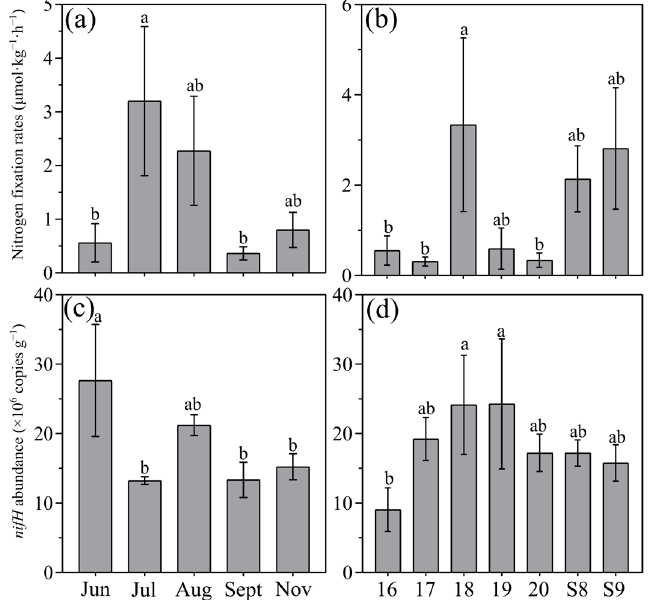
Figure 2. The variation of nitrogen fixation rates ( a , b ) and nifH gene abundance ( c , d ) among cruises and sampling sites in surface sediments from the Muping Marine Ranch. Different letters represent significant differences at p < 0.05 by ANOVA and LSD test in different cruises and sites.